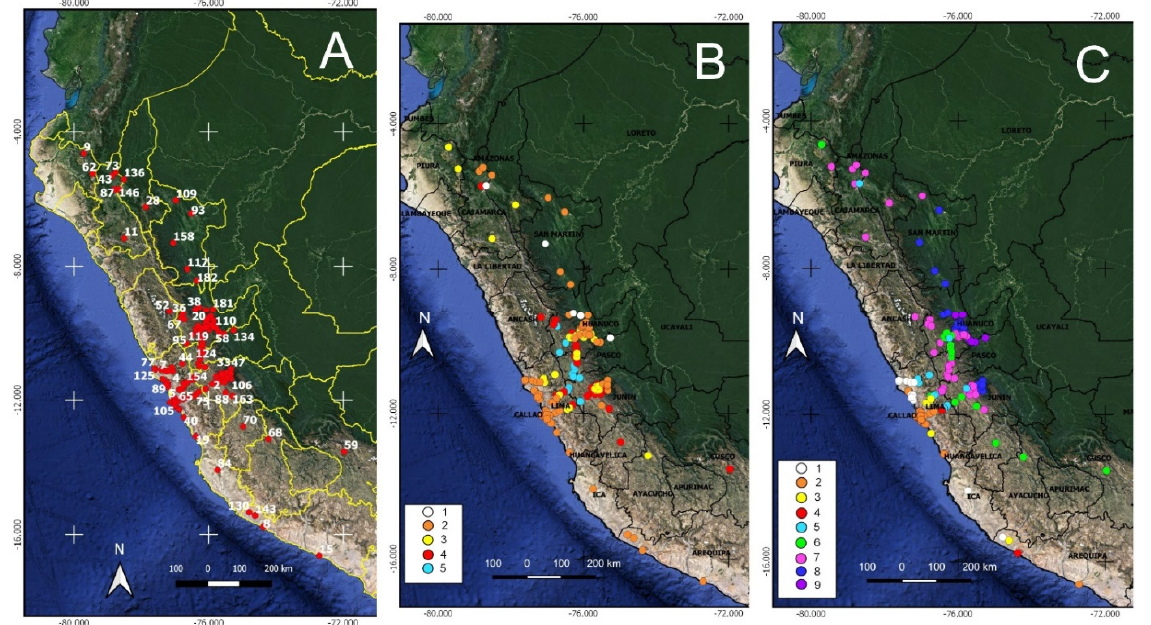
Figure 1. ( A ) Localities of the expedition of Ruiz and Pavón throughout Peru; ( B ) bioclimatic belt in each locality (1. infratropical; 2. thermotropical; 3. mesotropical; 4. supratropical; 5. orotropical); ( C ) ombrotype in each locality (1. ultra − hyperarid; 2. hyperarid; 3. arid; 4. semiarid; 5. dry; 6. subhumid; 7. humid; 8. hyperhumid; 9. ultra − hyperhumid).